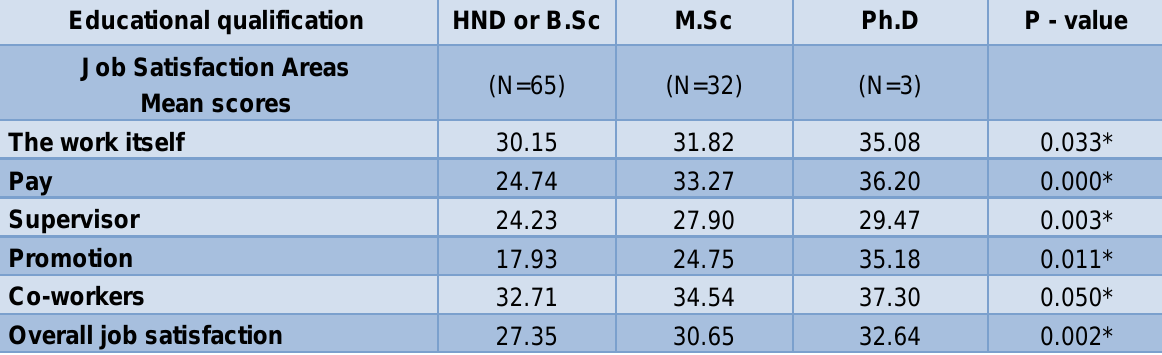
Table 5 Differences in Job satisfaction means based on Education (n=100) (One-Way ANOVA) * Denotes significant differences among groups at the 0.05